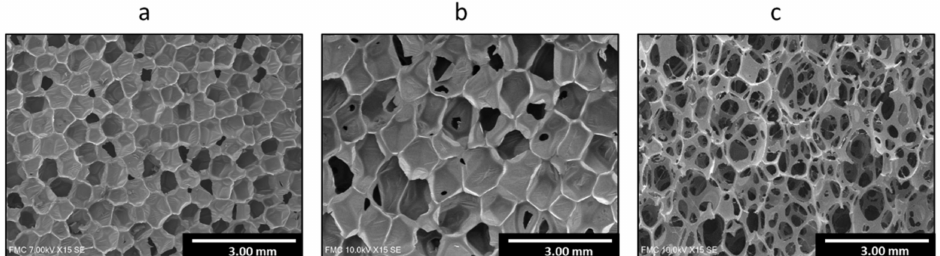
Figure 1. Typical cellular structures for closed cell rigid PU foam ( a ), hybrid rigid PU foam ( b ) and open cell PU foam ( c